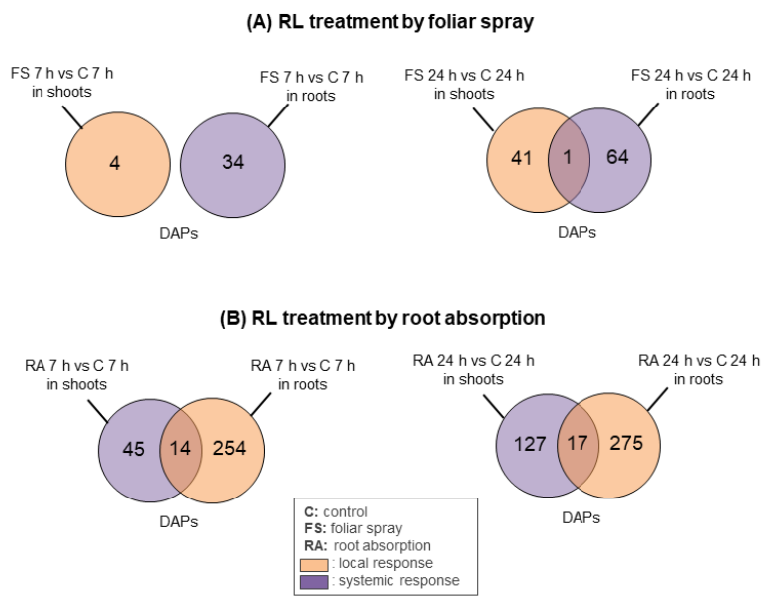
Figure 2. Venn diagrams of differentially accumulated proteins (DAPs) in shoots and roots of B. napus var. Darmor- bzh treated with RLs versus control. Four RL treatment conditions were tested: foliar spray treatment ( A ) and root absorption treatment ( B ), during 7 h or 24 h. These experiments were performed on three biological replicates.